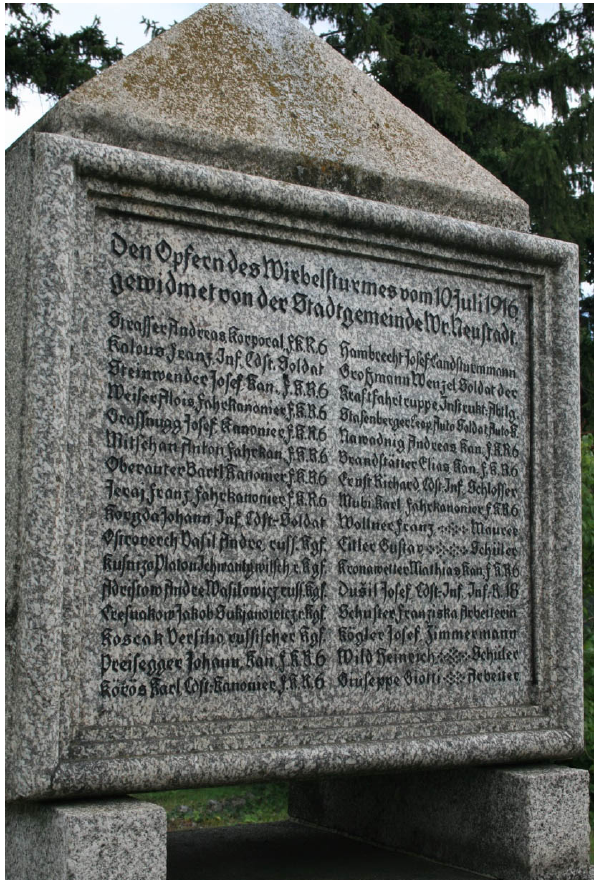
Figure 7. Memorial in the cemetery of Wiener Neustadt, erected above the common grave of 32 of the tornado victims. Text: Den Opfern des Wirbelsturmes vom 10. Juli 1916 gewidmet von der Stadtgemeinde Wr. Neustadt [Namens- und Berufsliste] – Transla- tion: “Dedicated to the victims of the whirlwind of 10 July 1916 by the City of Wiener Neustadt [list of names and affiliations]. Photo: Alois M.